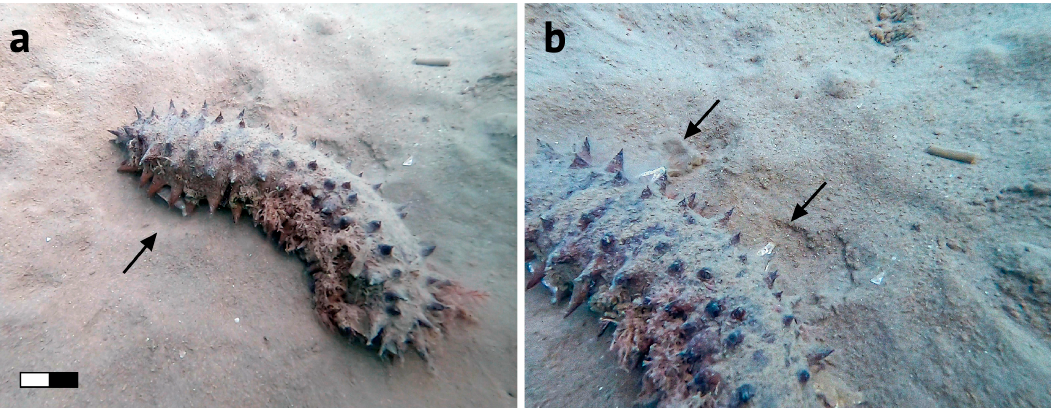
Figure 1. Sea cucumber as a shelter for juvenile fish. Overview ( a ) and close-up ( b ) of the sea cucumber, Holothuria arguinensis , resting on the soft-bottom habitat. Arrows show juveniles of Senegal’s sea bream Diplodus bellottii sheltering under the sea cucumber’s body. Scale bar: 5 cm.